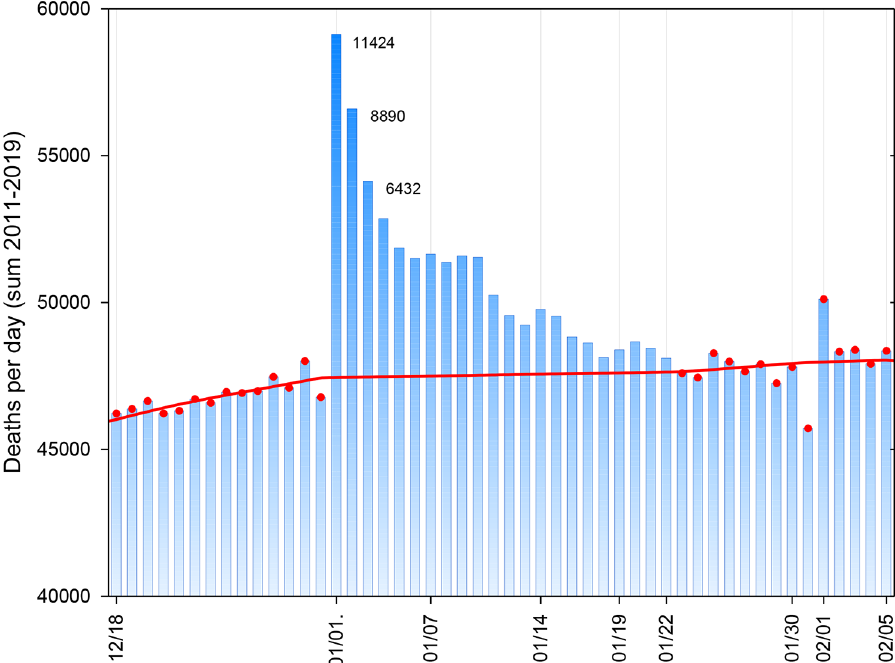
Fig. 2. The daily number of deaths in Russia from December 18 to February 5, the sum of indicators for 2011–2019 (blue bars) non-holidays and the LOWESS moving average extrapolated to holidays (red line). Note: Non-holidays are marked with red dots. Major holidays, as well as the end of the excess mortality period (January 22) are marked with dotted lines and the date on the abscissa. The numbers on the graph correspond to the excess deaths estimates for January 1–3. Source: authors’ calculations based on modelling and Rosstat